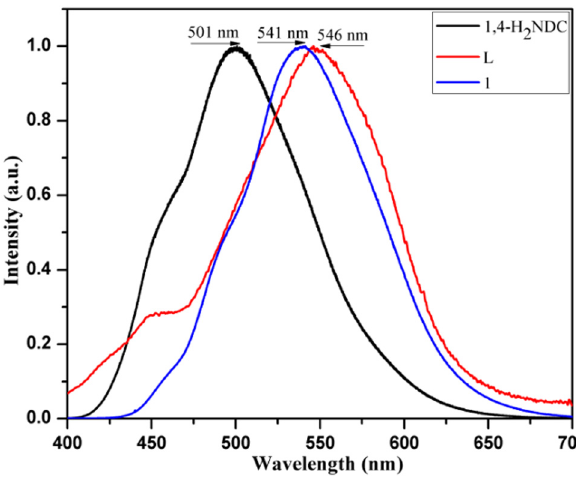
Figure 8: The solid - state photoluminescent properties of 1 .